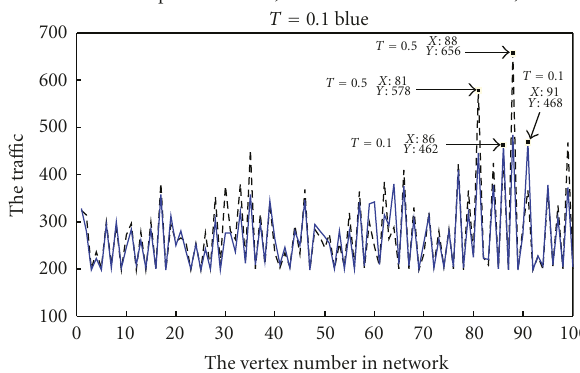
Compare the tra ffi c, threshold = 0 . 5 dashed black,